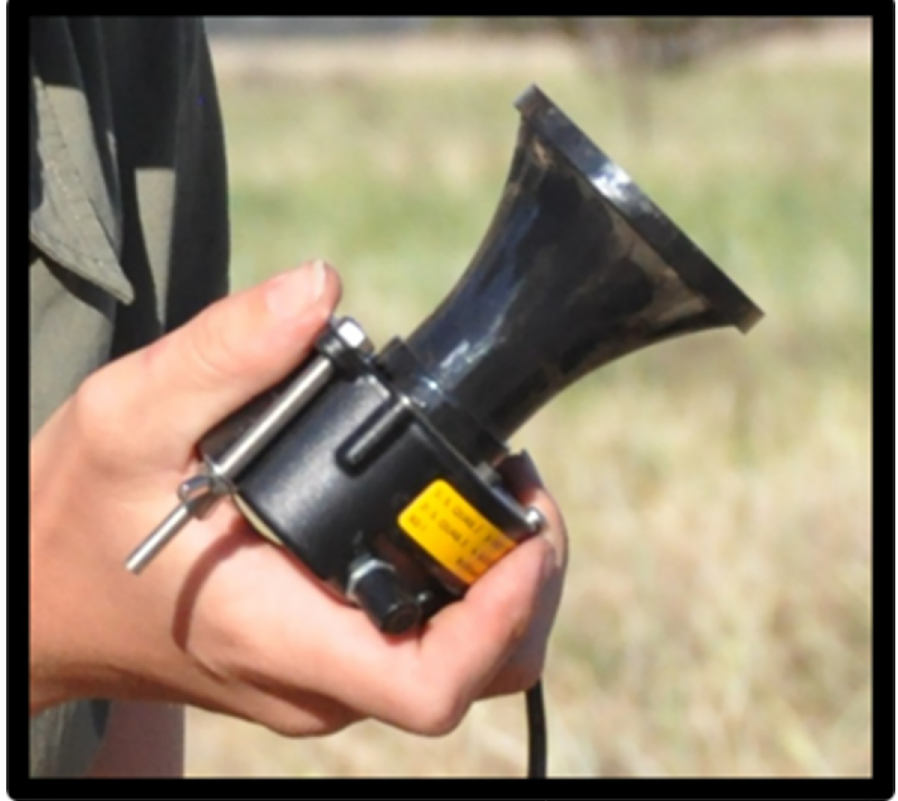
Fig 2. Photo of a QG-25 ‘quail caller’ Electronic Acoustic Lure (EAL) used to attract stubble quail ( Coturnix pectoralis ) on a private cropping property in south-eastern Australia,